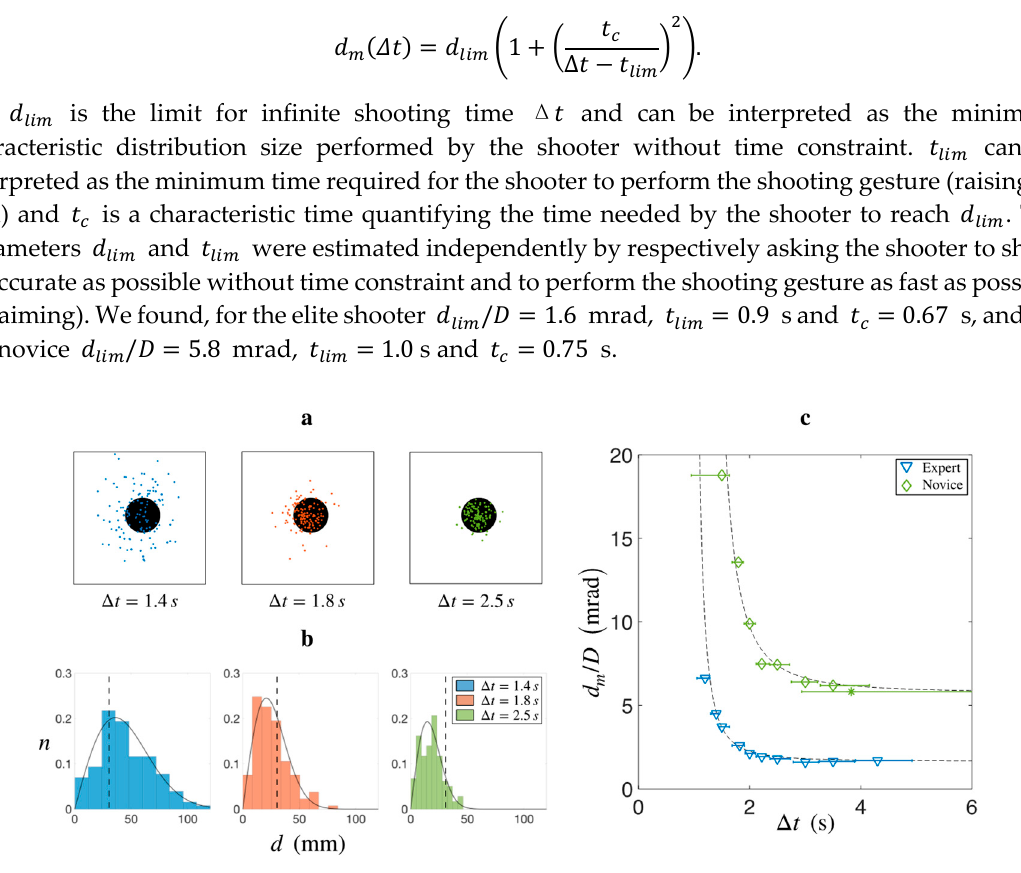
Figure 2. The evolution of accuracy with shooting speed. ( a ) View of the repartition of the shots for the pacing left to right Δ 𝑡 = 1.4 s, Δ 𝑡 = 1.8 s and Δ 𝑡 = 2.5 s, performed by the elite pentathlete. The black disk represents the target of radius 𝑟 (cid:3047) = 29.75 mm. The colored points represent the location of the shots. ( b ) Distribution of radial positions of shots for the aforementioned cadences. We plot in black the corresponding radial Gaussian curves, as given by Equation (1). The black vertical lines materialize the radius of the target. ( c ) Mean distance of the shots from the center of the target for different shooting cadences, divided by the shooting distance. For each cadence given by the metronome, the horizontal bar represents the distribution of the real shooting time taken by the shooter. It is plotted for two persons: The elite pentathlete (blue triangles) and the novice (green